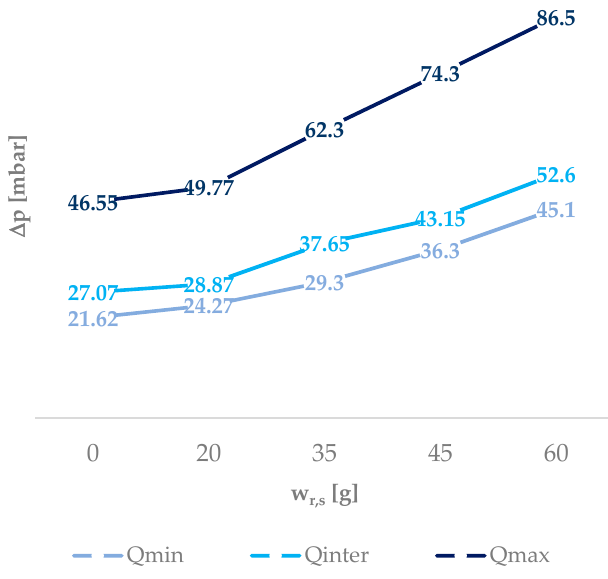
Figure 12. Pressure drop ∆ p trend obtained by clogging filters with fine gravel.